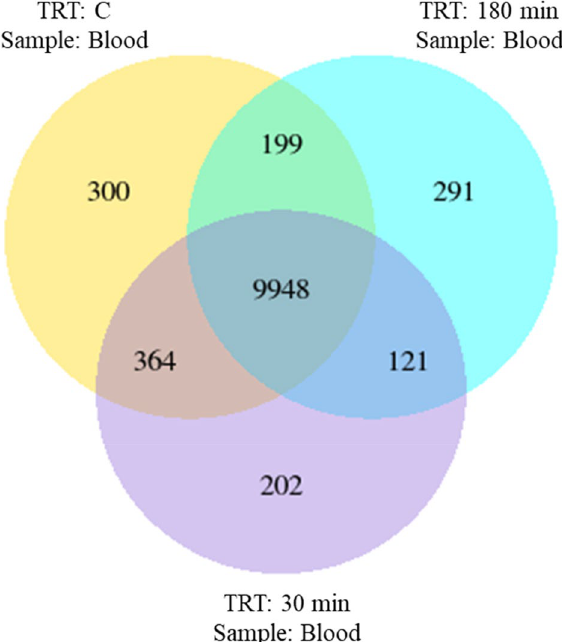
Figure 4. Venn diagram showing the co-expression of genes in blood samples from goats subjected to stress treatments (TRT: control, C = not transported but held in pens; 30 min = transported for 30 min; or 180 min = transported for 180 min).